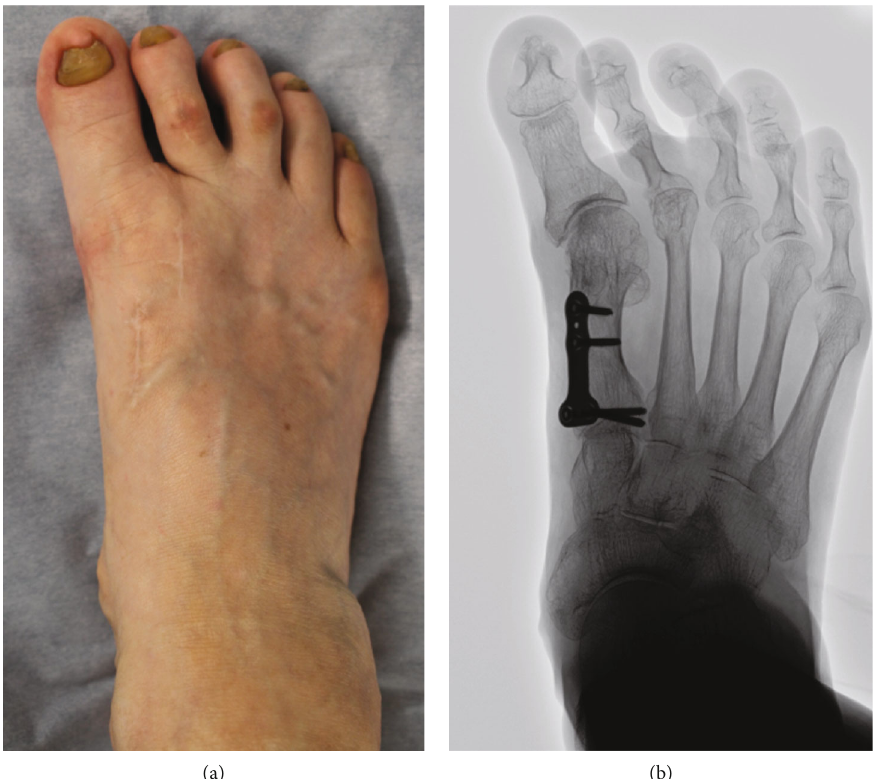
Figure 1: Preoperative appearance (a) and plain radiograph in the standing position (b). The hallux valgus angle was -24 ° and the intermetatarsal angle 0 °